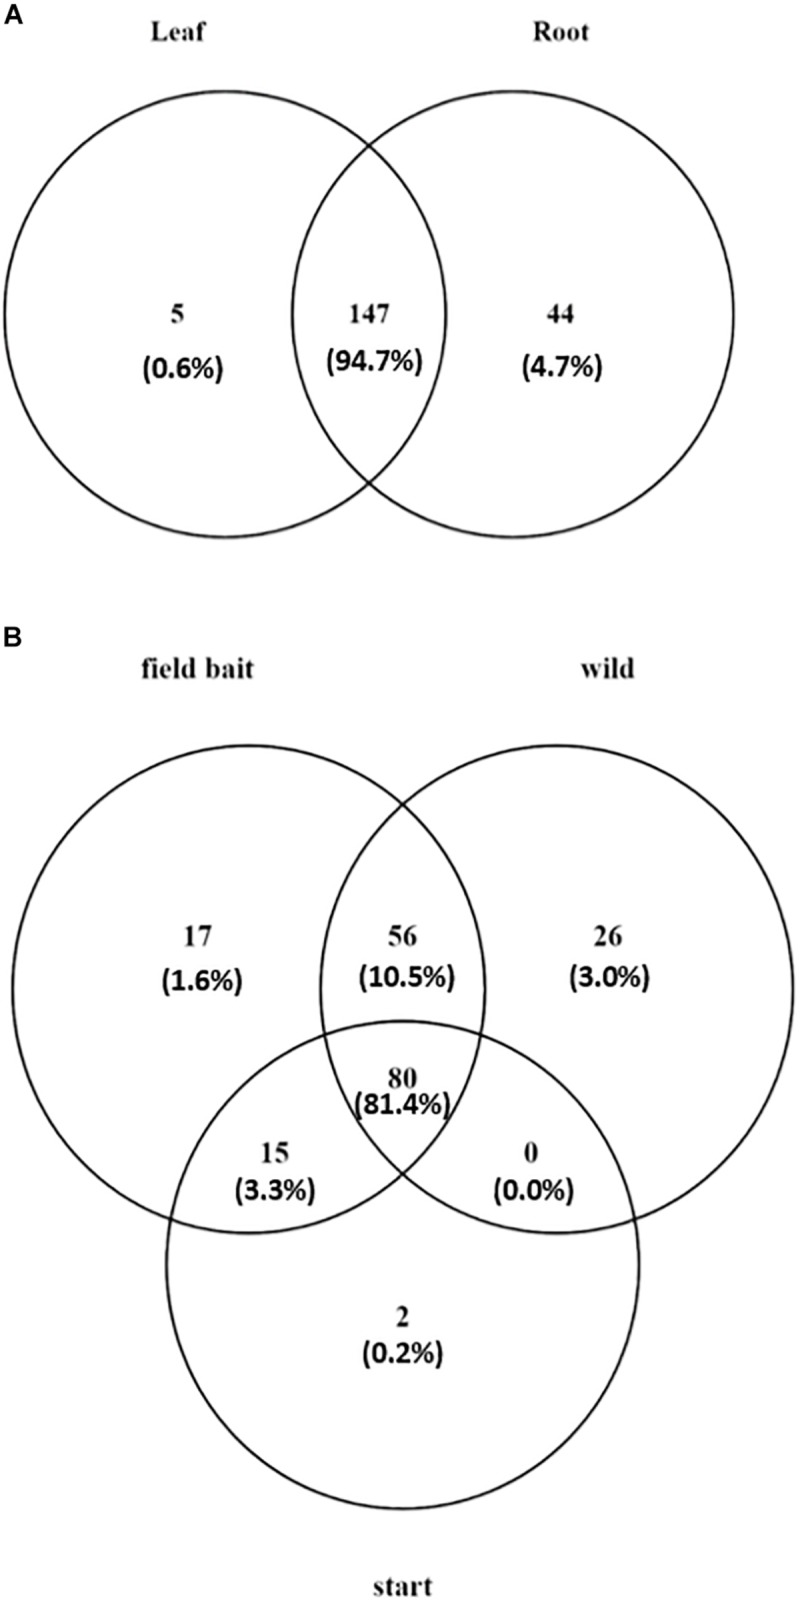
Venn diagram showing (A) number of tissue specific OTUs and OTUs present in both tissues in O. digyna, with %relative abundance of total sample set reads in parentheses, (B) number of OTUs present in different sample groups with %relative abundance of total sample set reads in parentheses. Field bait group combined the August bait plants and over-wintered bait plants. OTUs were clustered at 97% similarity level.